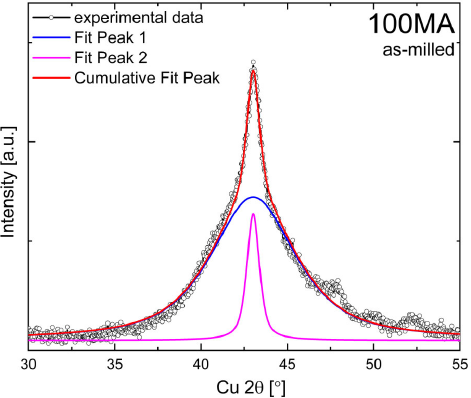
Figure 2. Pseudo ‐ Voigt curves fitted to experimental XRD pattern of as ‐ milled 100MA.